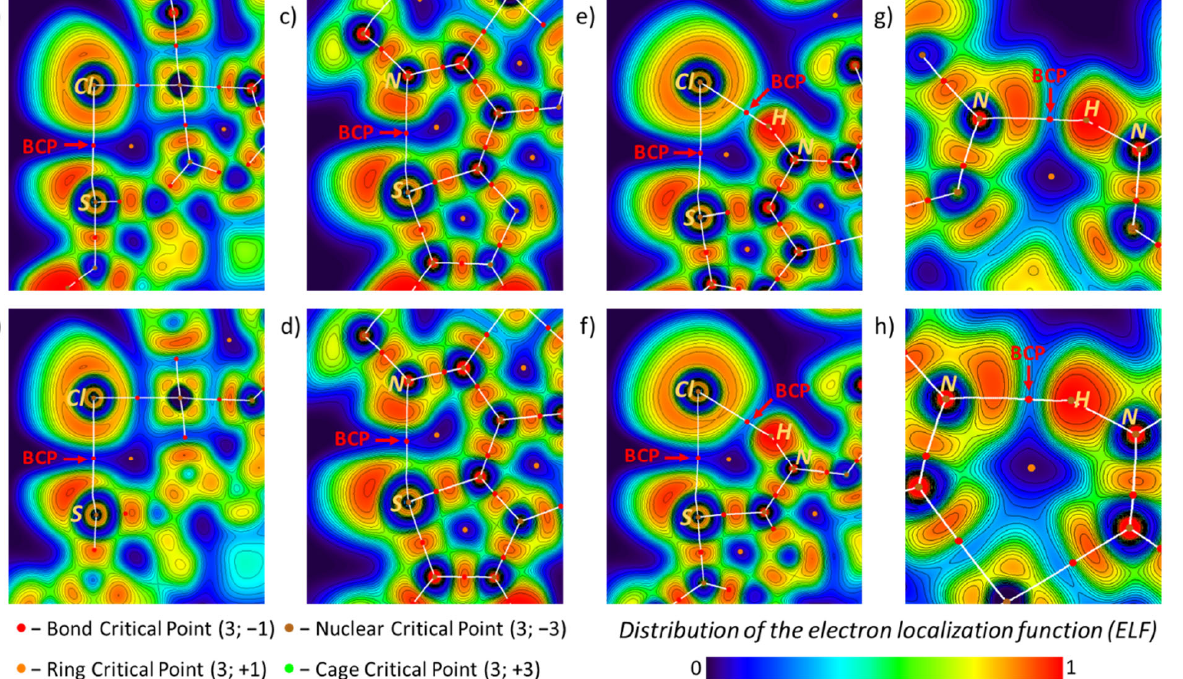
Figure 4. Visualization of the electron localization function (ELF), QTAIM bond critical point (BCP), and bond paths (white lines) corresponding S ··· Cl chalcogen bonds in structures of 4a ( a ) and 4b ( b ), S ··· N chalcogen bonds in structures of 5a ( c ) and 5b ( d ), bifurcated chalcogen-hydrogen bonds μ (S,N − H) Cl in structures of 6 ( e ) and 7 ( f ), and N–H ··· N hydrogen bonds in structures of 6 ( g ) and 7 ( h ). Table 3. Noncovalent interactions in the structures of complexes: geometrical parameters of non ‐ covalent interactions (Å and deg), values of the density of all electrons multiplied on sign( λ 2 )—sign( λ 2 ) ρ (r), Laplacian of electron density— ∇ 2 ρ (r), energy density—H(r), potential ener ‐ gy density—V(r), and Lagrangian kinetic energy—G(r) (a.u.) at the BCPs (3, –1), energies of non ‐ covalent interactions defined by two approaches.